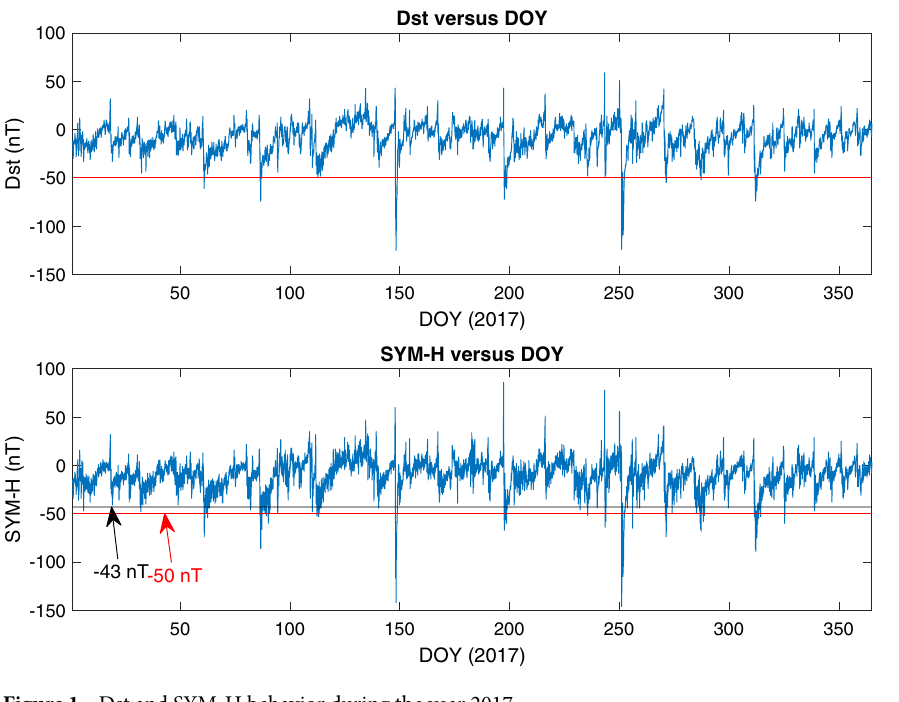
Figure 1. Dst and SYM-H behavior during the year